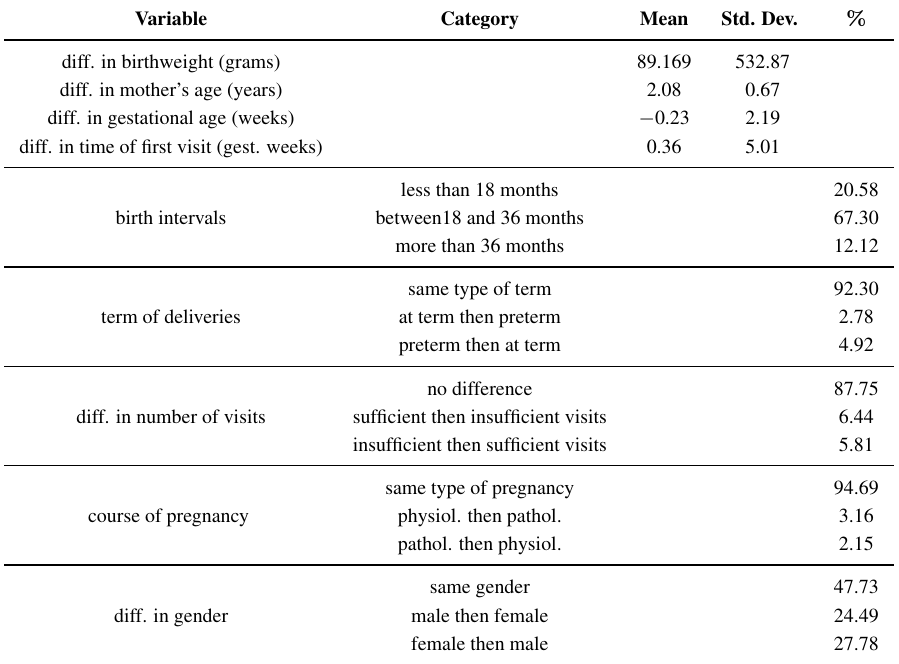
Table 2. Distribution of differences between second newborns and first newborns: mean and standard deviation for quantitative variables and percentage values for categorical